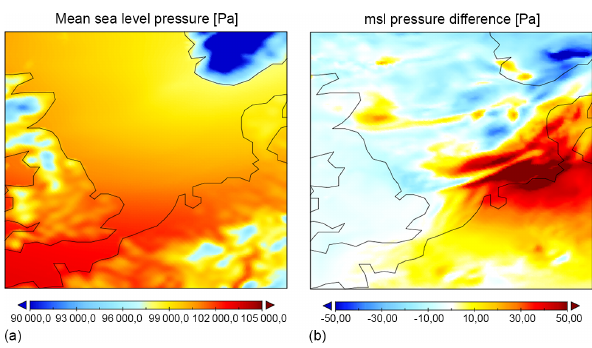
Figure 11. (a) COSMO pressure (Pa) at mean sea level height in the North Sea during storm Xaver and (b) mean sea level pressure differences when comparing one-way minus two-way coupled mod- elling).